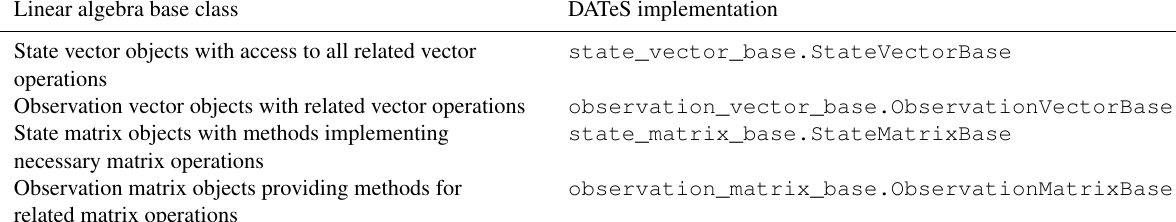
Table 1. DA filtering routines provided by the initial version of DATeS (v1.0).